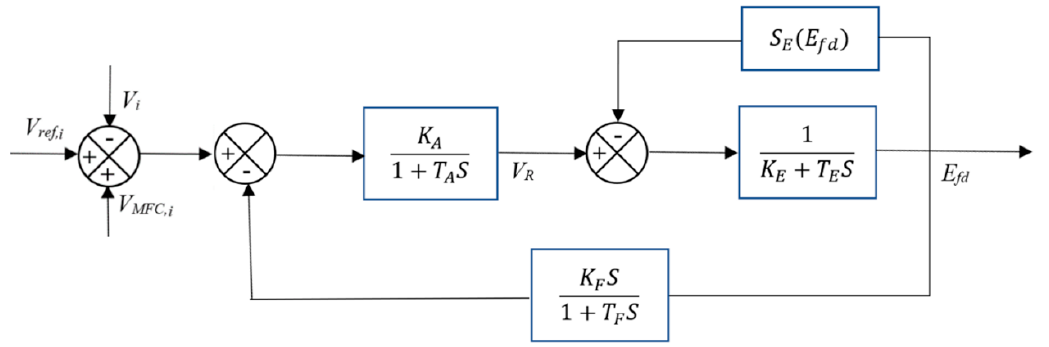
Figure 8. IEEE Type-I exciter.